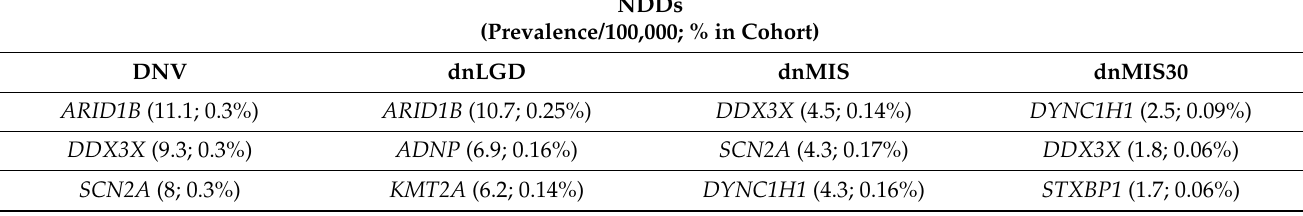
Figure 1. Prevalence of DNVs by gene extrapolated from percent of cases in total NDD cohort. Genes are indicated along the x -axis, with prevalence of each variant type on the y -axis. ( A ) NDD DNV cases, ( B ) NDD dnLGD cases, ( C ) NDD dnMIS cases, and ( D ) NDD dnMIS30 cases. The proportion of each gene and mutation type in our cohort was multiplied by the estimated prevalence of NDDs (DD/ID, ASD, and epilepsy) from Zablotsky and Black, 2020. Table 2. Top 10 most prevalent genes with variation among NDDs. Prevalence figures are normalized by constraint scores, thus may account a higher percentage of our